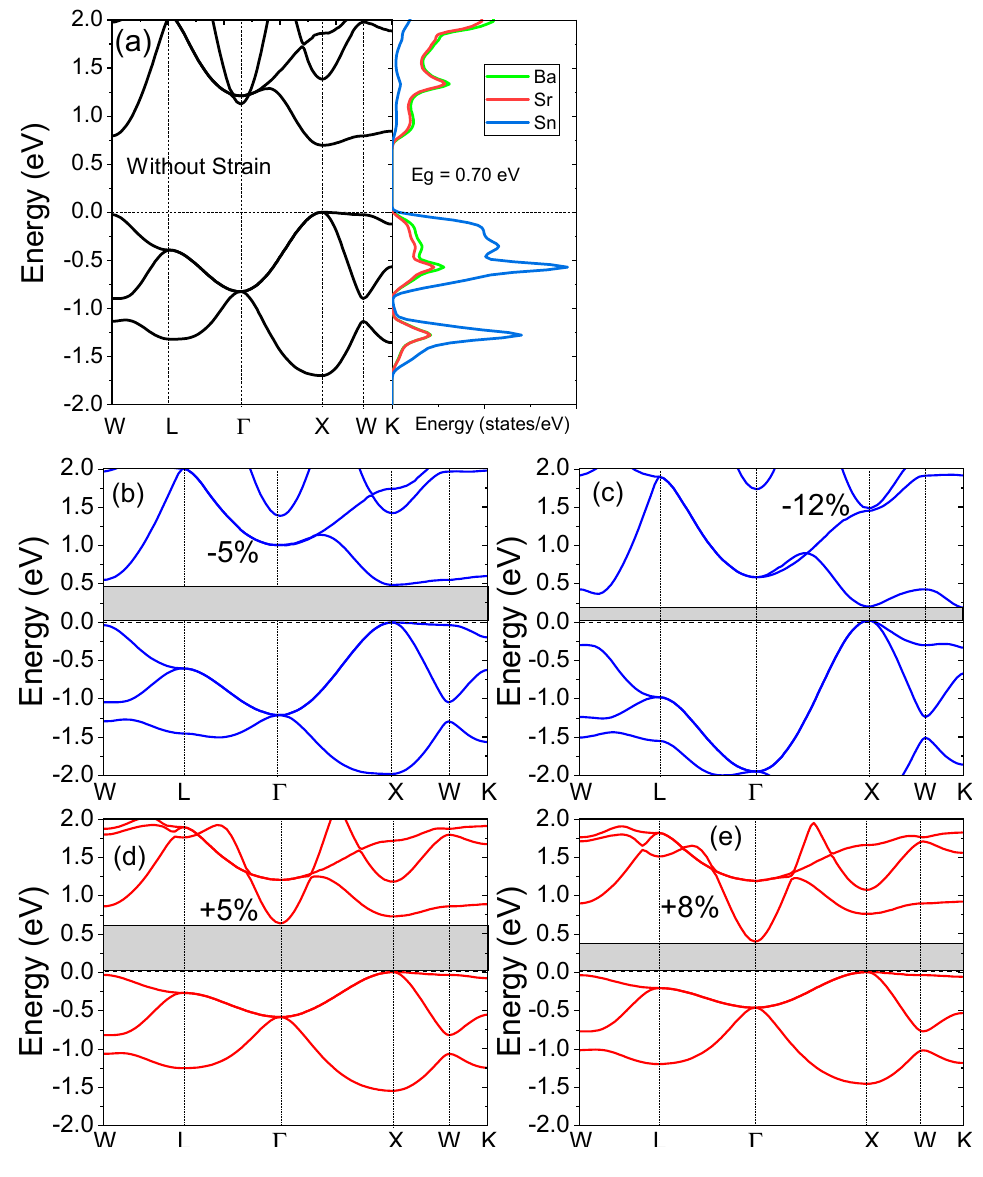
Figure 3. ( a ) Electronic structure and projected density of states (pDOS) with zero strain, ( b ) − 5%, ( c ) − 12%, ( d ) +5% and ( e ) +8% strain applied to the electronic structures of the SrBaSn material.